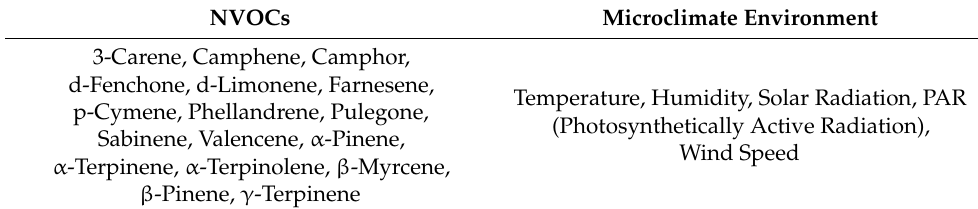
Table 1. NVOCs and microclimate environment measurement factors. NVOCs Microclimate Environment 3-Carene, Camphene, Camphor, Temperature, Humidity, Solar Radiation, PAR (Photosynthetically Active Radiation), Sabinene, Valencene, α -Pinene, Wind α -Terpinene, α -Terpinolene, β -Myrcene, β -Pinene, γ -Terpinene